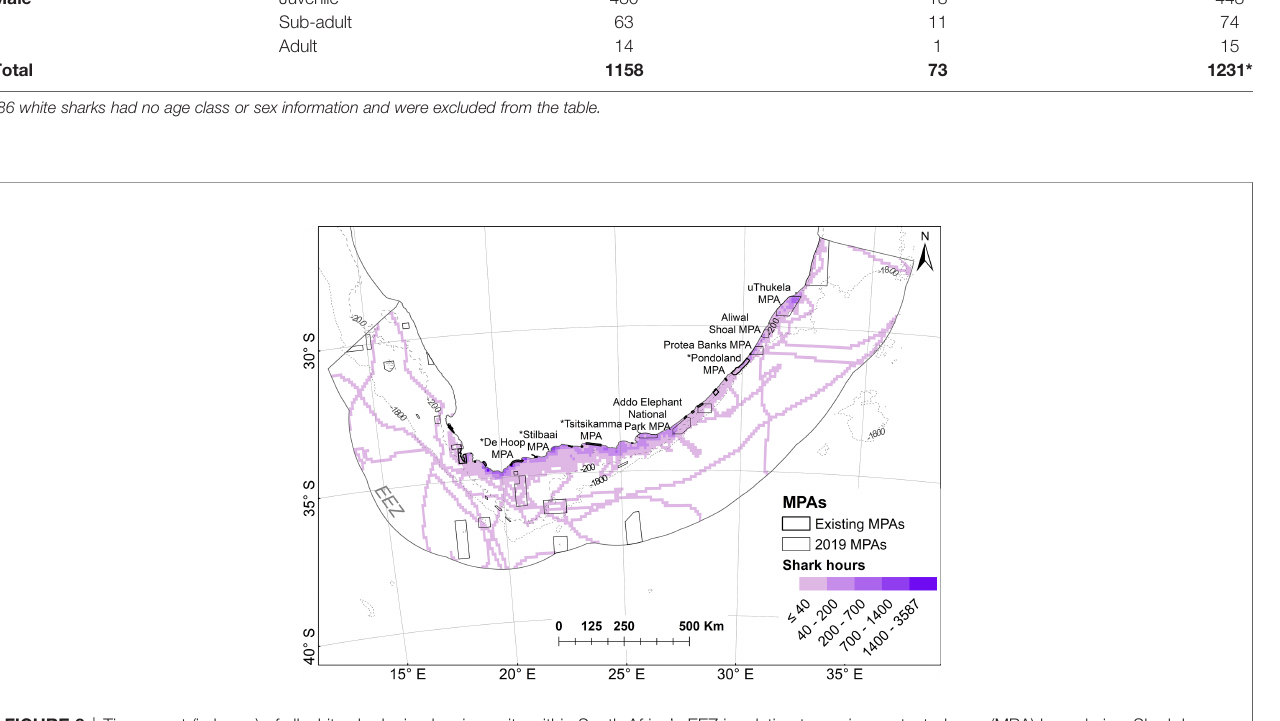
FIGURE 8 | Time spent (in hours) of all white sharks in planning units within South Africa ’ s EEZ in relation to marine protected area (MPA) boundaries. Shark hours are shaded on natural breaks in the data. MPAs in existence during tracking are referred to as “ existing ” MPAs and are indicated with a * in Figure 10 ; others were proclaimed in